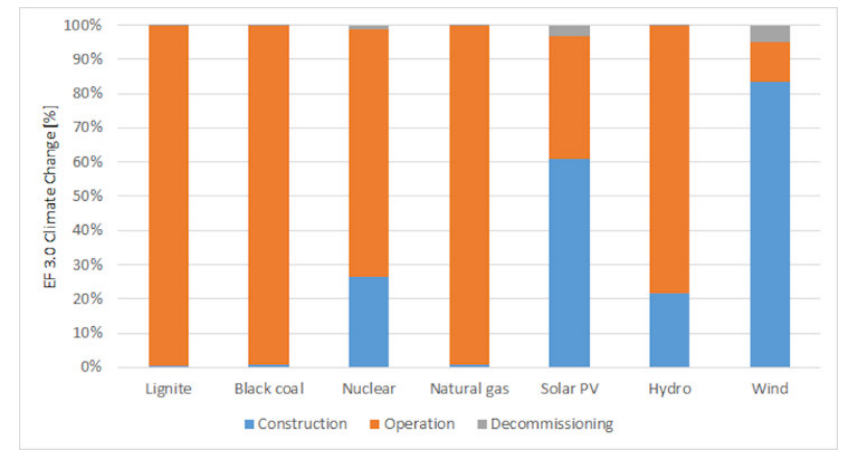
Figure 3. Contributions of the various life cycle phases (construction, operation and decommissioning) of energy sources to the climate change category. Environmental benefits excluded.